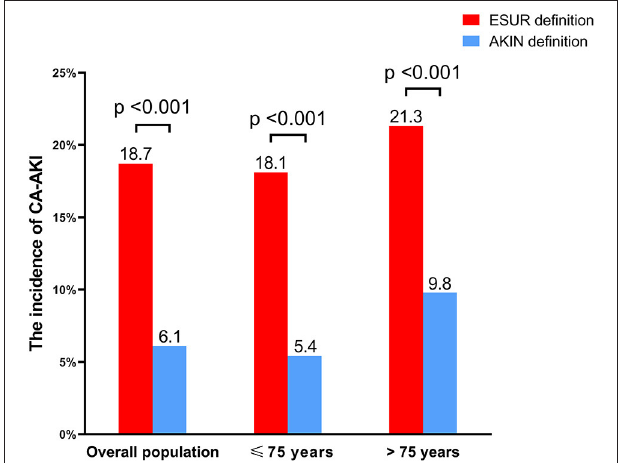
FIGURE 2 | The incidence of CA-AKI according to both AKIN and ESUR definitions. CA-AKI, contrast-associated acute kidney injury; AKIN, Acute Kidney Injury Network; ESUR, European Society of Urogenital Radiology.